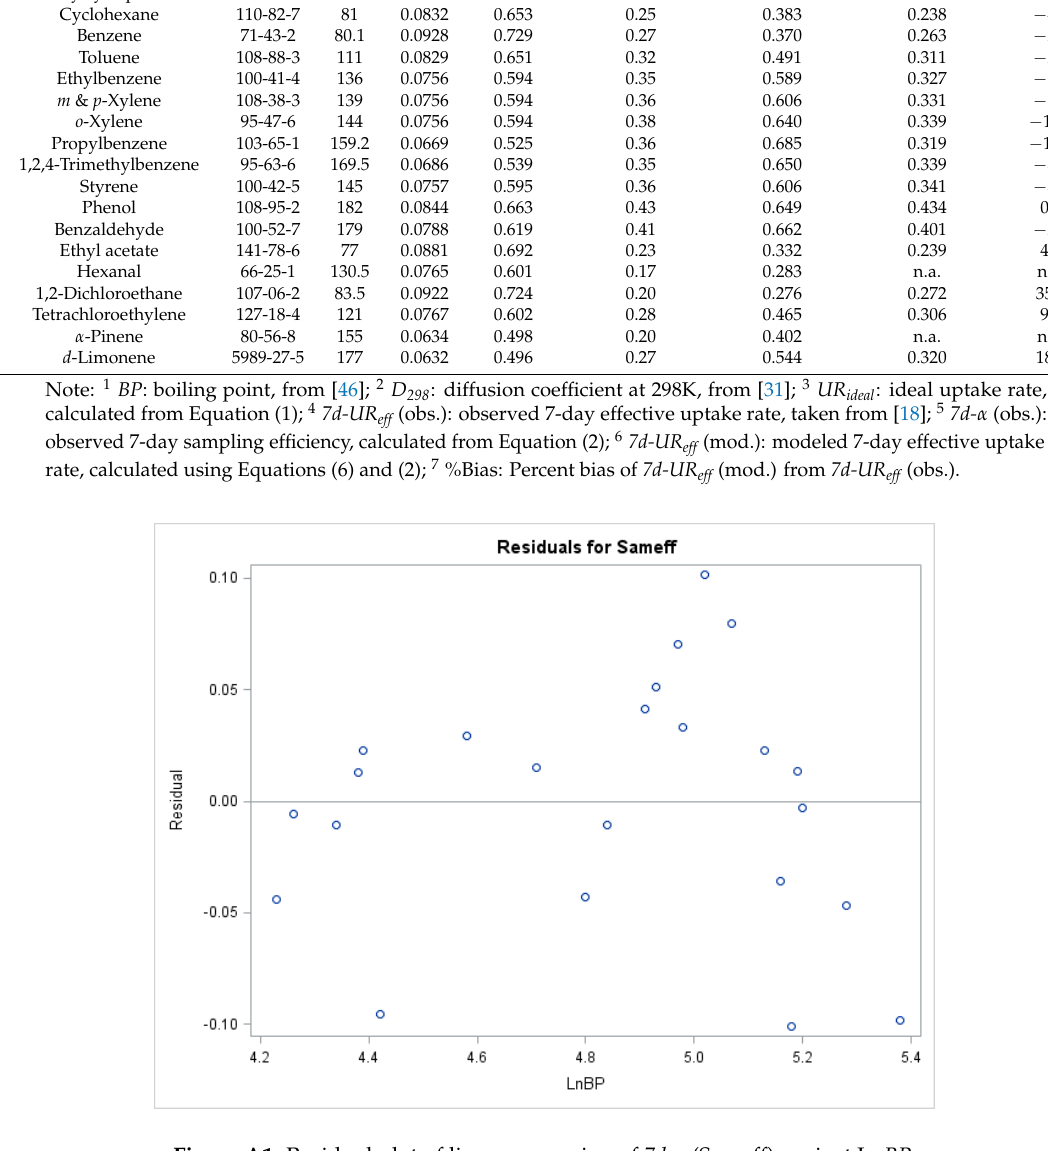
Figure A1. Residual plot of linear regression of 7d- α (Sameff) against Ln BP .